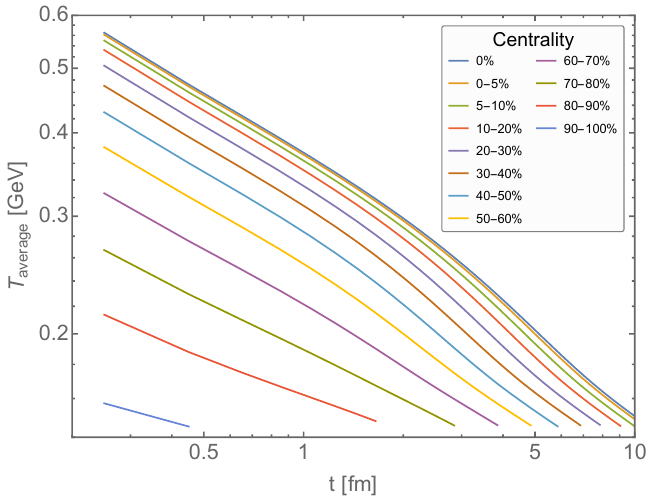
Figure 4 . Path-averaged temperature evolution used for our calculations. Lines from top to bottom correspond to the centrality classes listed in table